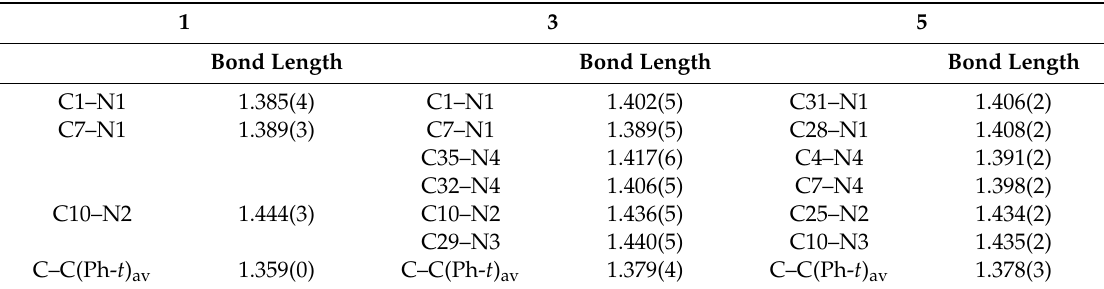
Table 2. Selected bond lengths (Å) and torsion angles ( ◦ ) for 1 , 3 , and